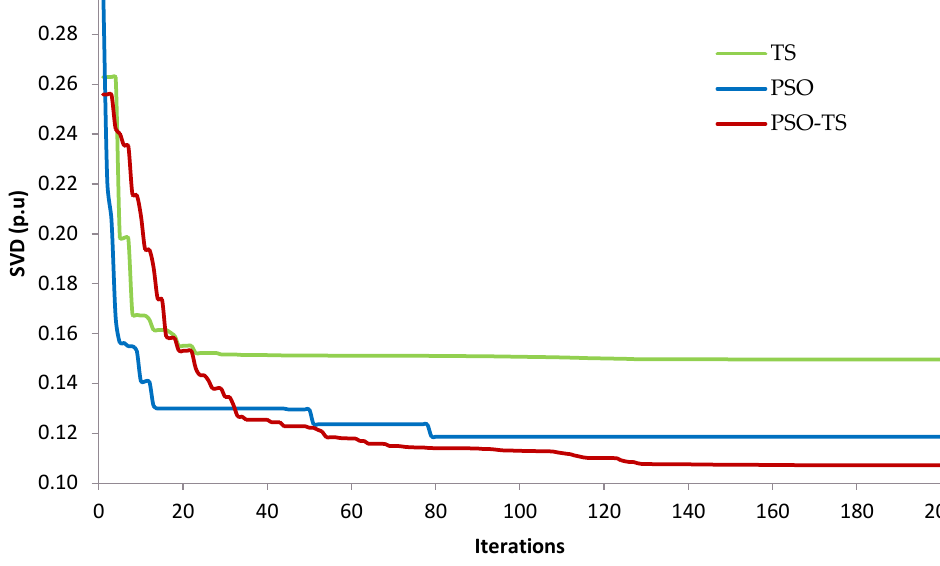
Figure 12. Convergence characteristic of the voltage deviation objective (SVD) (Case 2).